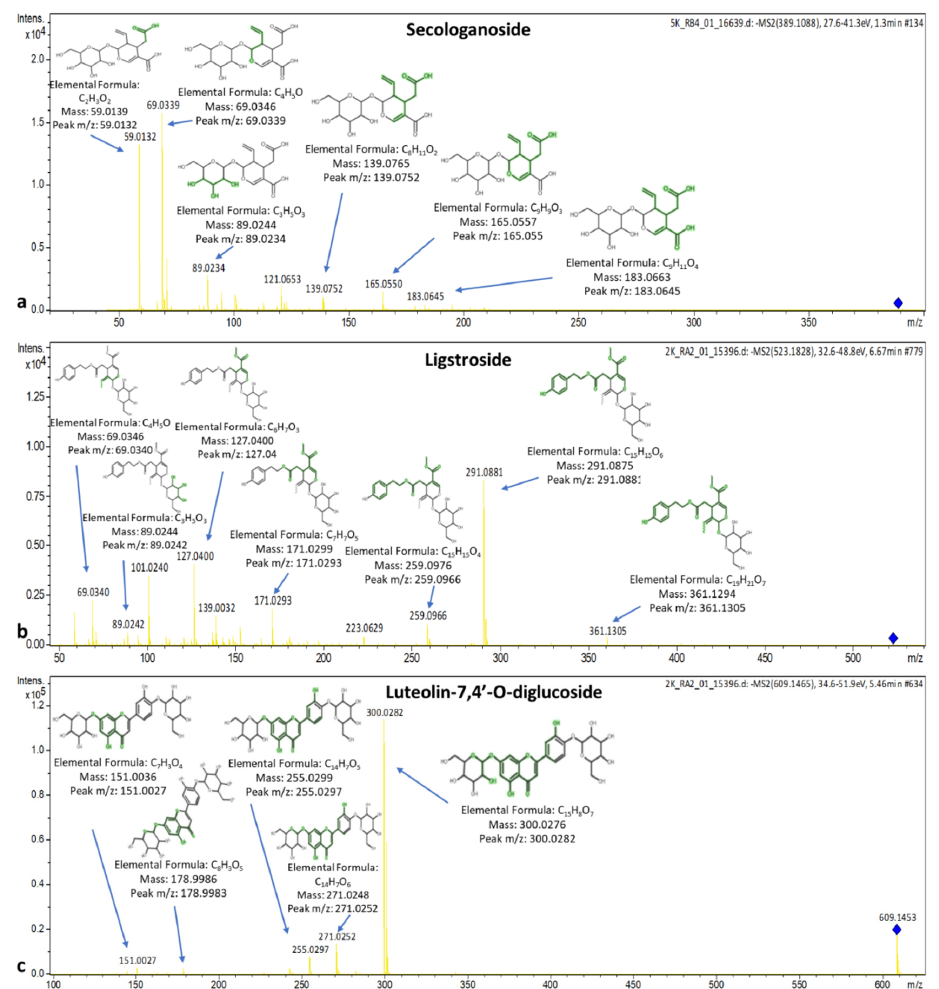
Figure 14. Spectra and MS/MS fragments of ( a ) secologanoside, ( b ) ligstroside, and ( c ) luteolin 7,4 ′ - O - diglucoside.